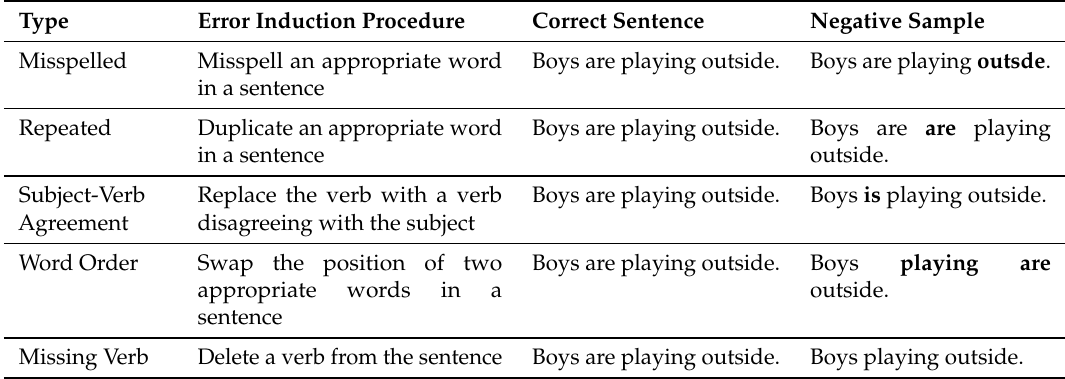
Table 2. Examples of General Errors.